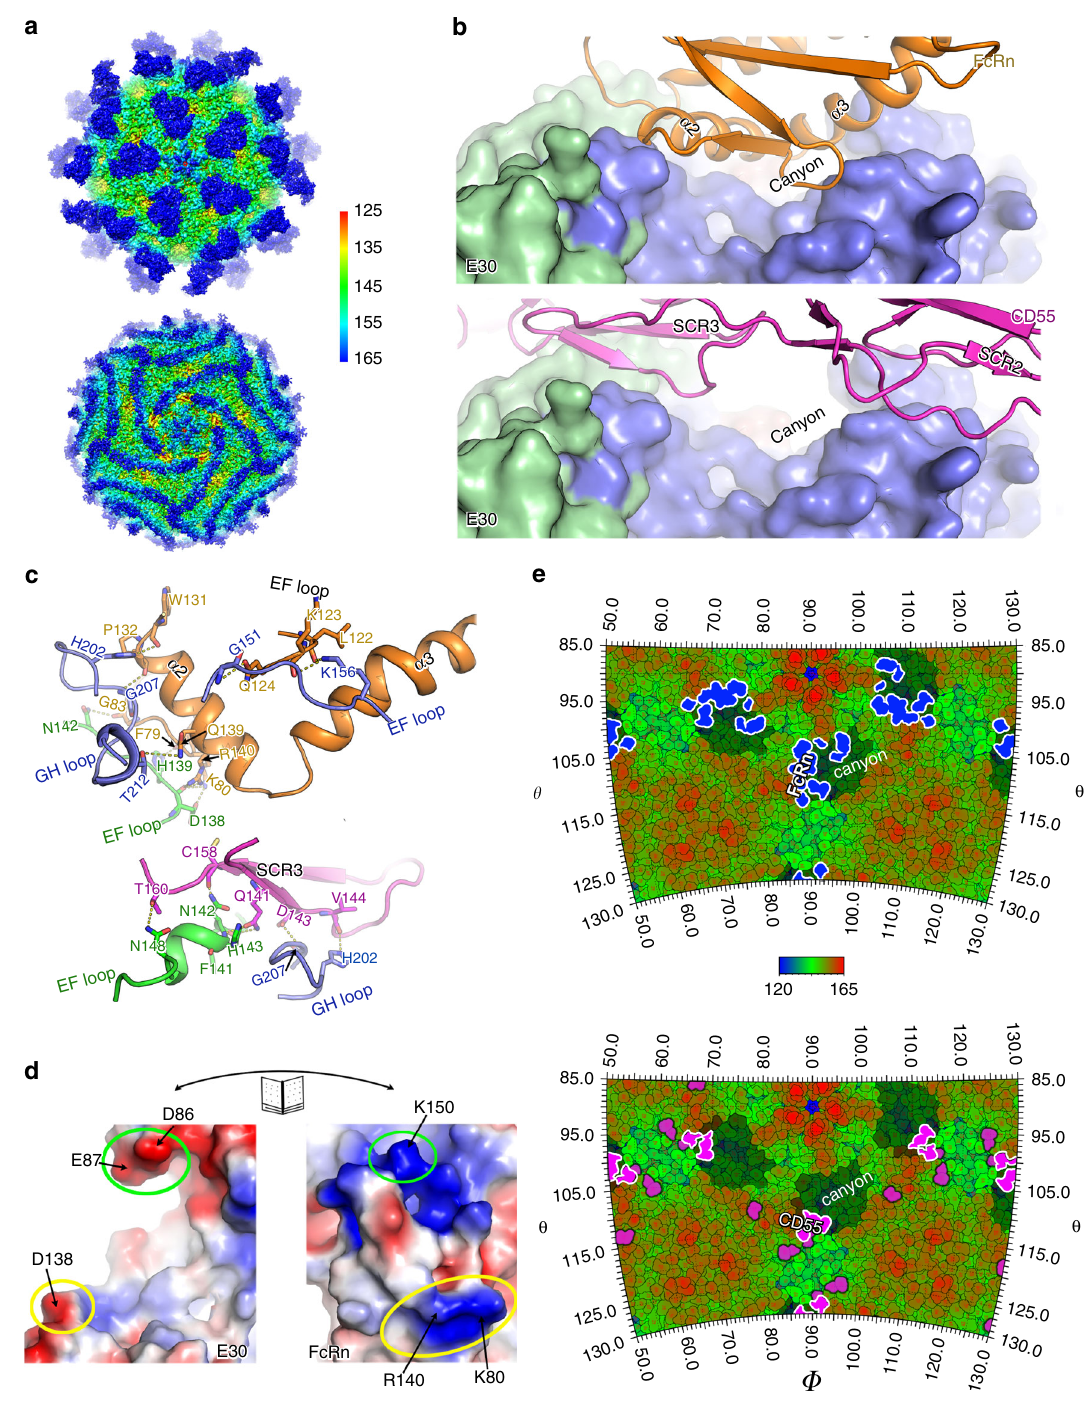
Fig. 3 Structural details of the interaction between E30 and its uncoating (FcRn) or attachment (CD55) receptor. a Surface representation of E30-FcRn complex (up) and E30-CD55-complex (down) along the icosahedral fi vefold axes. The surfaces are colored by radius as shown in the color bar right. b Platform for receptors (FcRn, top and CD5, bottom) binding with E30. The FcRn colored in orange and CD55 colored in magenta are shown in cartoon representation, and viral protomers as surface representation are applied in the same color scheme as in Fig. 1c. c Residues at the main E30-FcRn (up) and E30-CD55 (down) interfaces. The side or main chains involved in mutual interactions are shown as sticks. The hydrogen bonds are shown as yellow dashed lines and the color scheme adopted here is the same as above. d Electrostatic surface representation of E30 and FcRn. The surfaces are colored in a gradient of blue to red in accordance with positive to negative charge, respectively. And the residues in E30 are labeled and circled in the same color in respect to their interacting partners in FcRn. e Roadmap exhibiting the footprints of FcRn (up) or CD55 (down) on the surface of E30. The roadmaps are radius-colored from blue (120 nm) to red (165 nm) with θ and ϕ representing latitude and longitude, respectively. The canyons surrounding the fi vefold axes are shaded by shadow. The footprints of FcRn and CD55 are colored in blue and magenta, respectively, and the overlaps between the canyon and FcRn are circled in red lines and accentuated in dark